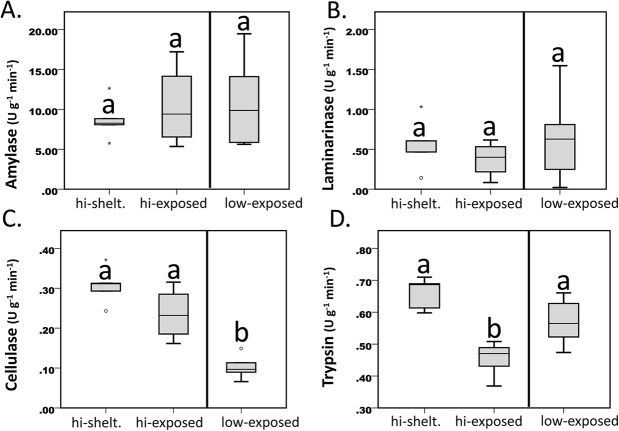
Field digestive enzyme activities. Digestive enzyme activity of (A) amylase, (B) laminarinase, (C) cellulase, and (D) trypsin in mussels sampled (N=5) from experimental plots. Box plots reveal the lower and upper quartiles (box), and the median (line within the box). The adjacent values mark the smallest and largest values not declared as outliers. A one-way ANOVA followed by Tukey's test was used to identify significant differences (P<0.05) in mean digestive enzyme activities between treatment groups, indicated by letters.